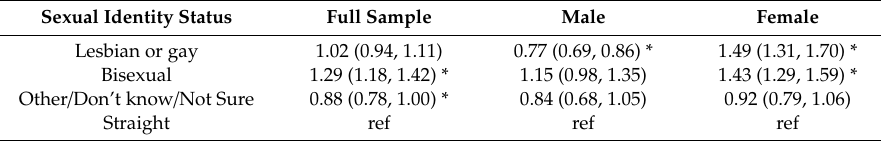
Table 4. Logistic regression of obesity (BMI ≥ 30) on sexual identity status and by